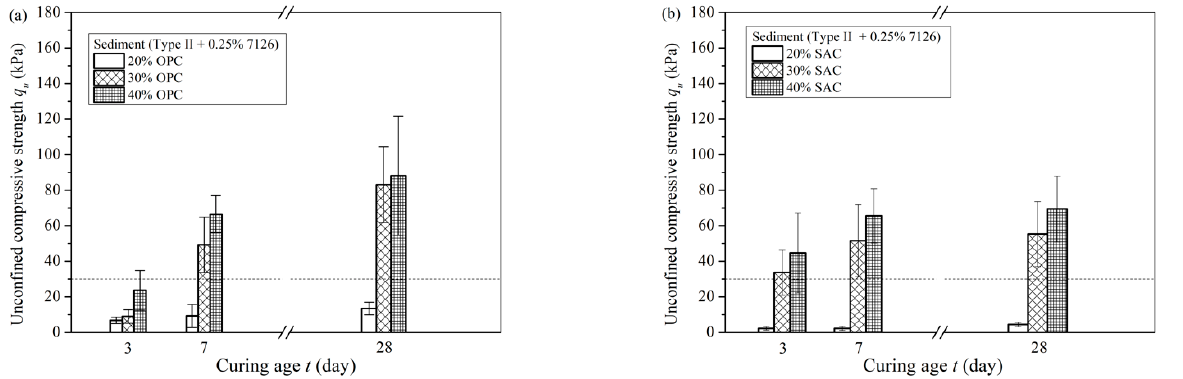
Figure 8. Unconfined compressive strength of the solidified sediment after APAM pretreatment. ( a ) OPC. ( b ) SAC.